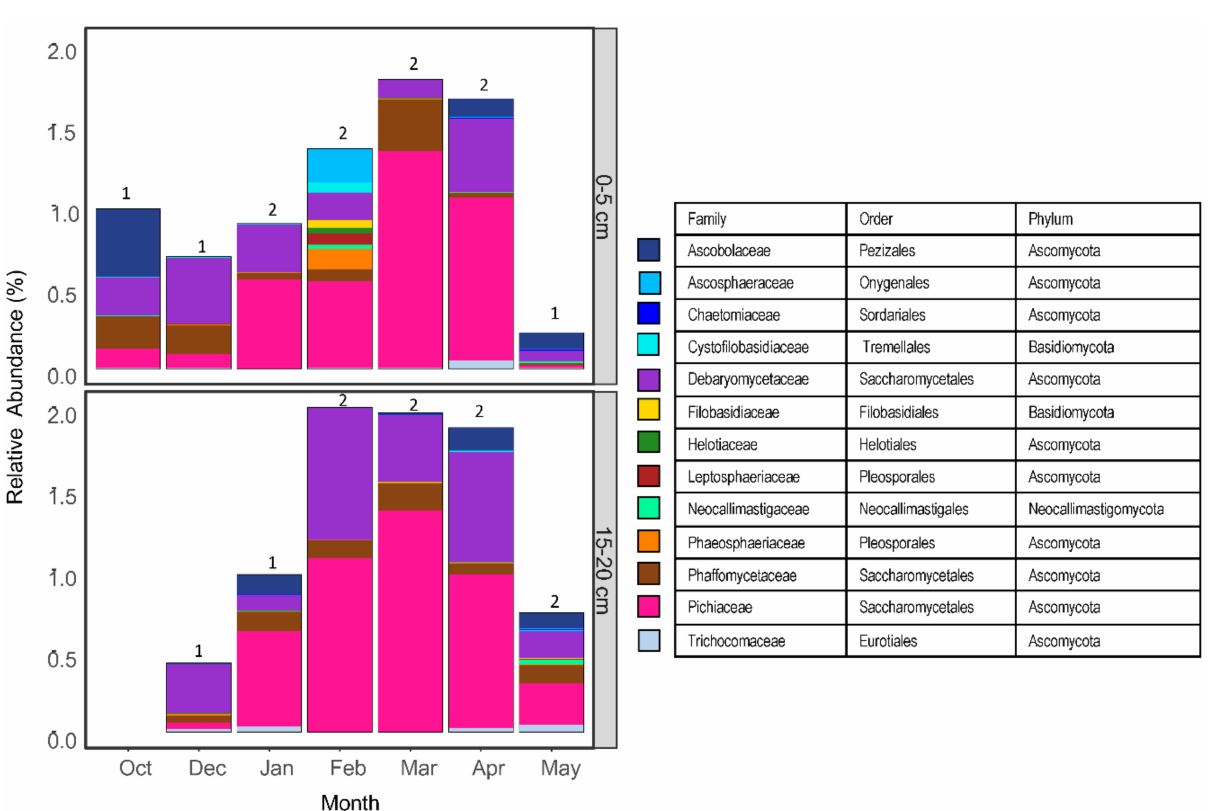
Figure 4. Relative abundance of fungal taxa (out of 82) that are represented in 45% of all samples split by depth and month at Farm C. The first date (October) is just the top layer because it is the beginning of the pack building. Sample size is illustrated above each bar. Microbiome varied by time (pseudo- F = 1.27, p =